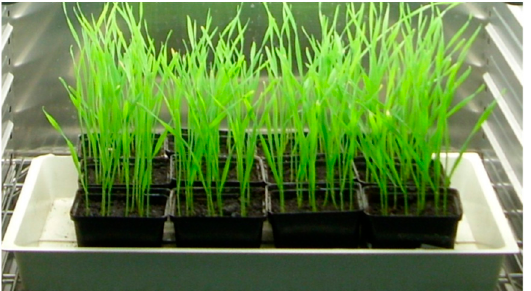
Figure 1. Tested wheat plants in the growing chamber after 20 days of growth.